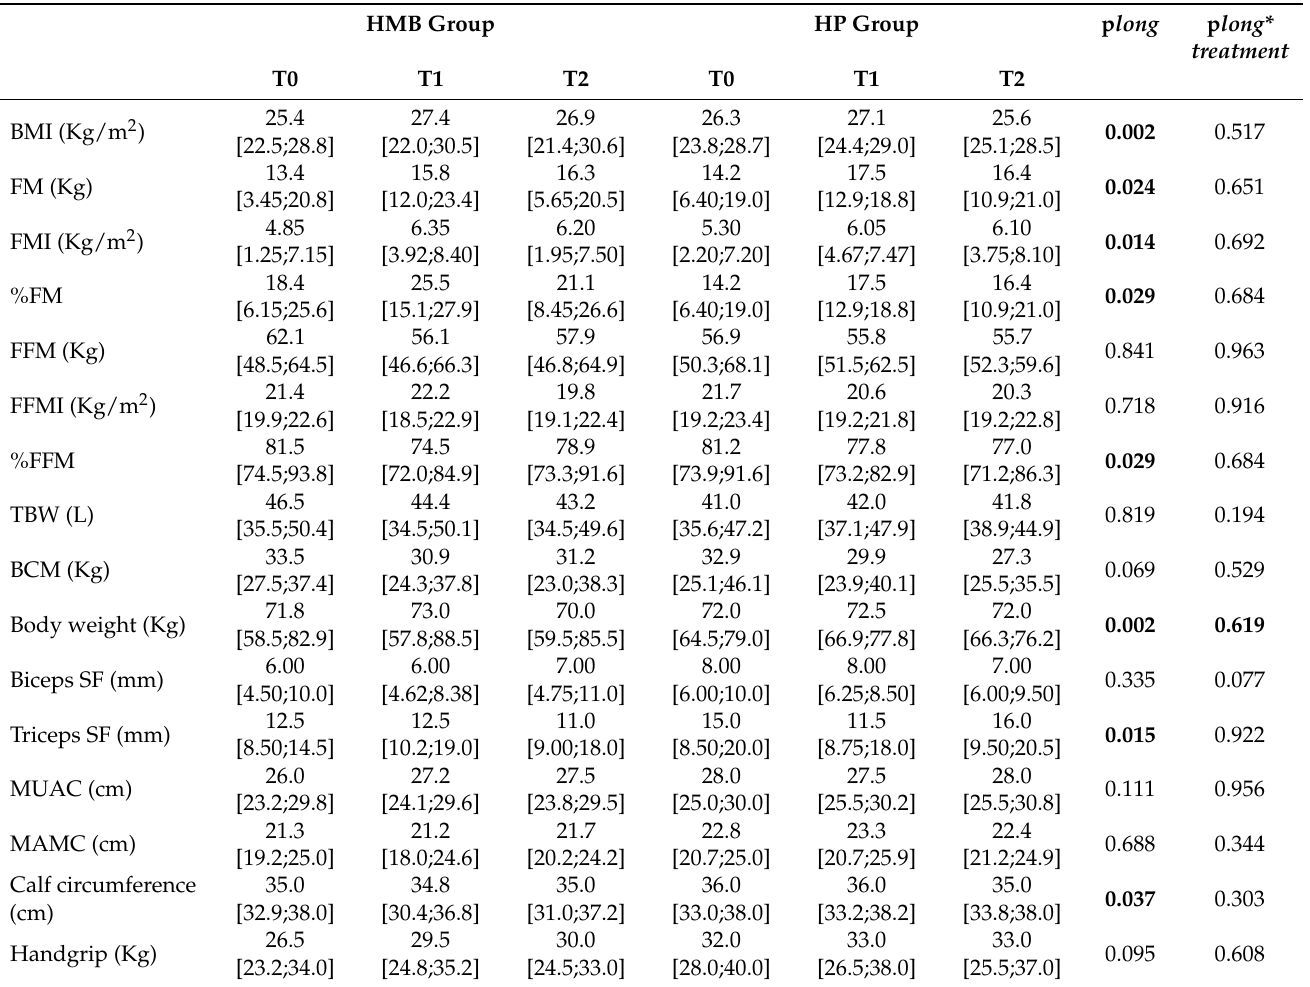
Table 2. Longitudinal changes in body composition and handgrip